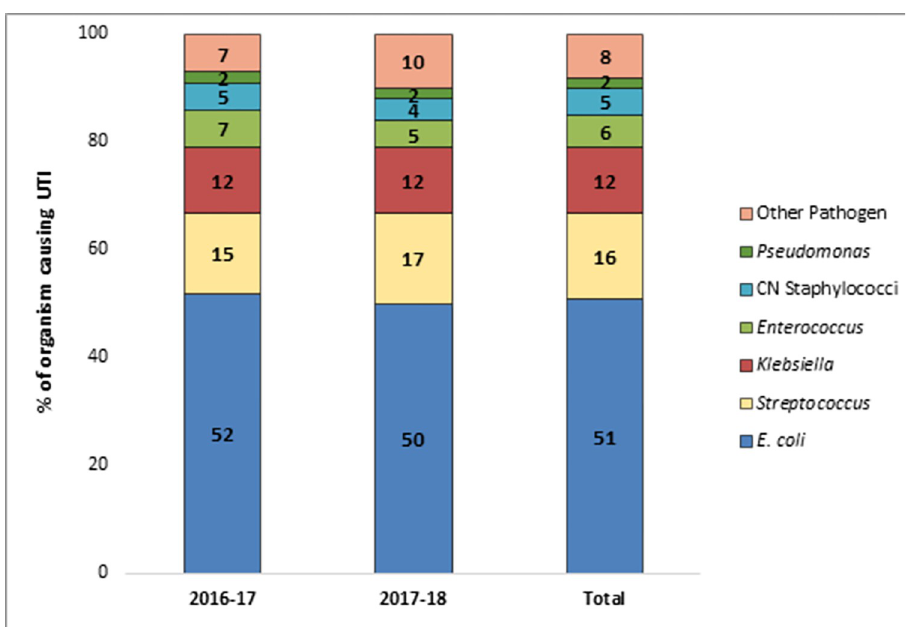
Fig 1. Prevalence of major bacterial pathogens causing community-acquired UTI among patients from 2016 to